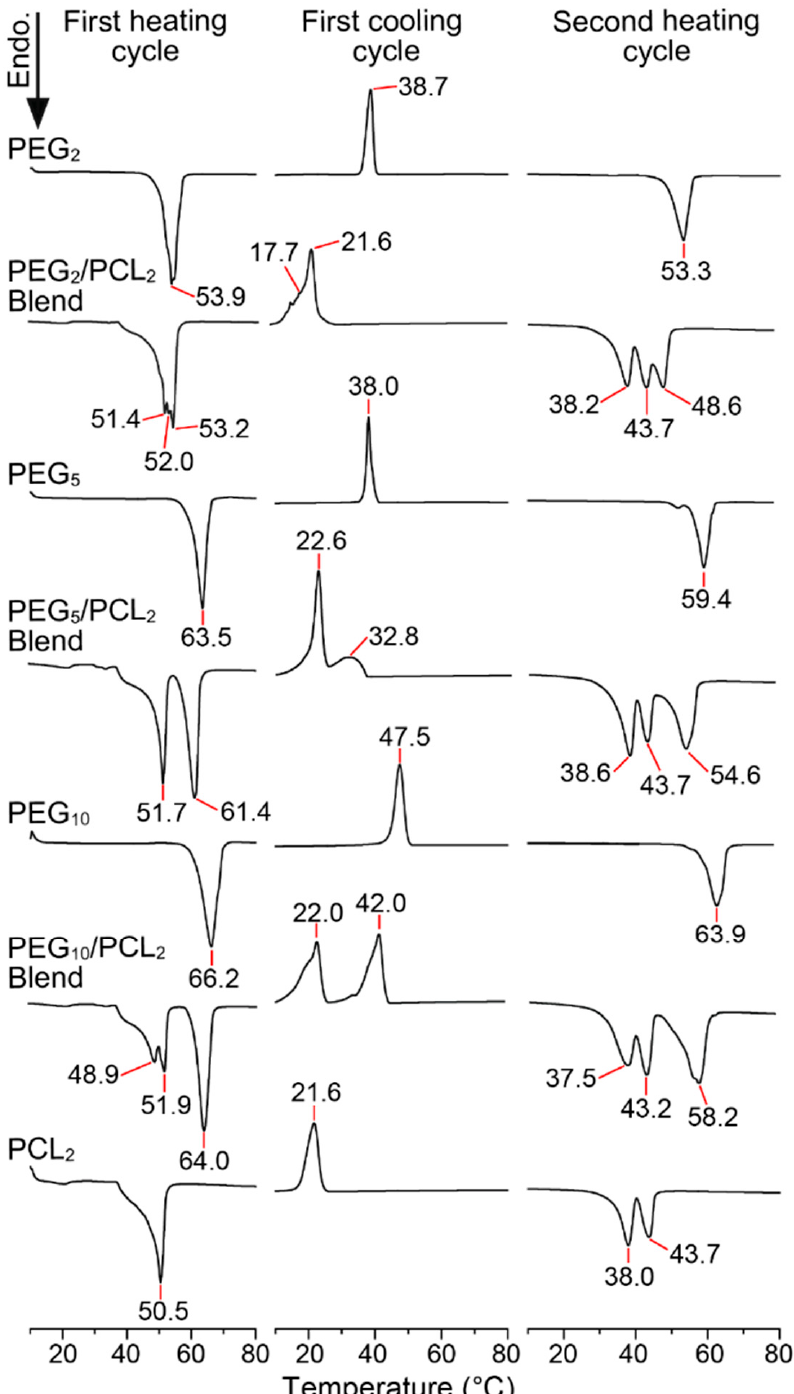
Figure 1. Representative DSC thermograms of PEG ( M n = 2, 5 and 10 kDa) and PCL ( M n = 2 kDa) homopolymers, and PEG/PCL homopolymer physical blends (1:1 w / w ) showing the first heating, first cooling, and second heating profiles (ramp rate 10 °C /min).